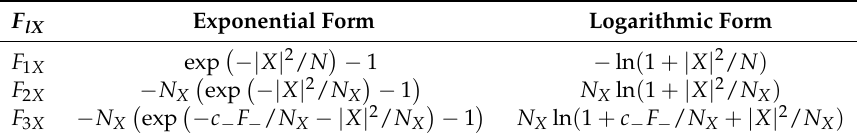
Table 2. Functional forms of F lX with l = 1,2,3 shown in the definition of K 1 , K 2 and K 3 in Equations (4a)–(4c)